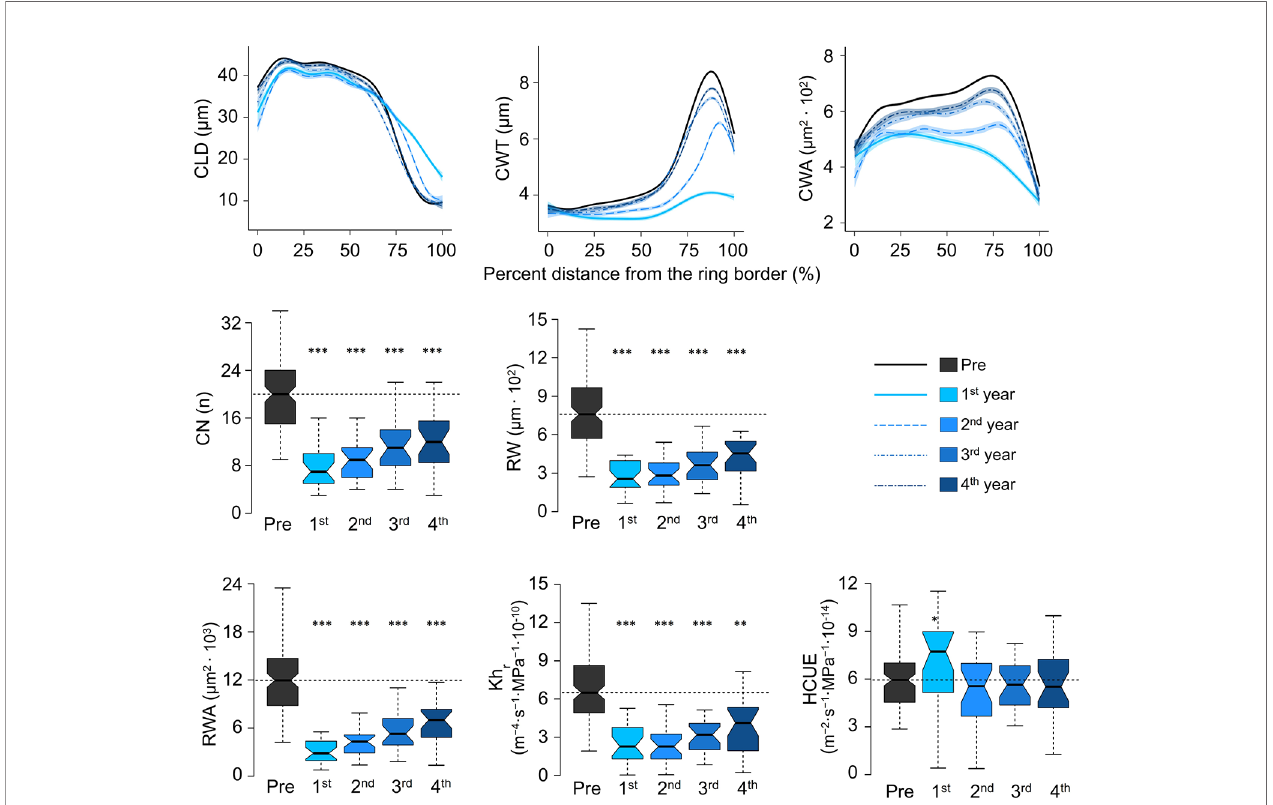
FIGURE 4 | Evolution of cell anatomical characteristics around the outbreak events for the four high-severity outbreaks (started in 1908, 1945, 1963, and 1972) at S19. Pre = average of the fi ve years before outbreak. 1 st is the year identi fi ed as outbreak start (see the key for correspondence between years and colors). CLD, cell lumen radial diameter; CWT, cell-wall thickness; CWA, cell wall area; CN, ring cell number; RW, ring width; Kh r , theoretical tree-ring hydraulic conductivity; RWA, ring wall area; HCUE, hydraulic carbon use ef fi ciency. CLD, CWT, and CWA are standardised as percent distance from the ring border. The ring-speci fi c pro fi les are loess fi ts, with standard error envelopes, of the anatomical parameter for each cell and its relative position in the ring. CN, RW, RWA, Kh r , and HCUE are calculated at the ring level and represented as box plots to indicate the median, interquartile range (IQR), con fi dence interval (notches, +/ − 1.58·IQR/ √ n), minimum and maximum values. Dashed horizontal lines indicate the median value during “ Pre ” . Asterisks indicate signi fi cant difference from the reference ( “ Pre ” ) at p < 0.05 (*), p < 0.01 (**), and p < 0.001 (***) according to Welch ’ s t-test. Boxplots of all mean parameters are represented in Supplementary Figure S3 . Pro fi les of all cell parameters are represented in Supplementary Figure S4 .